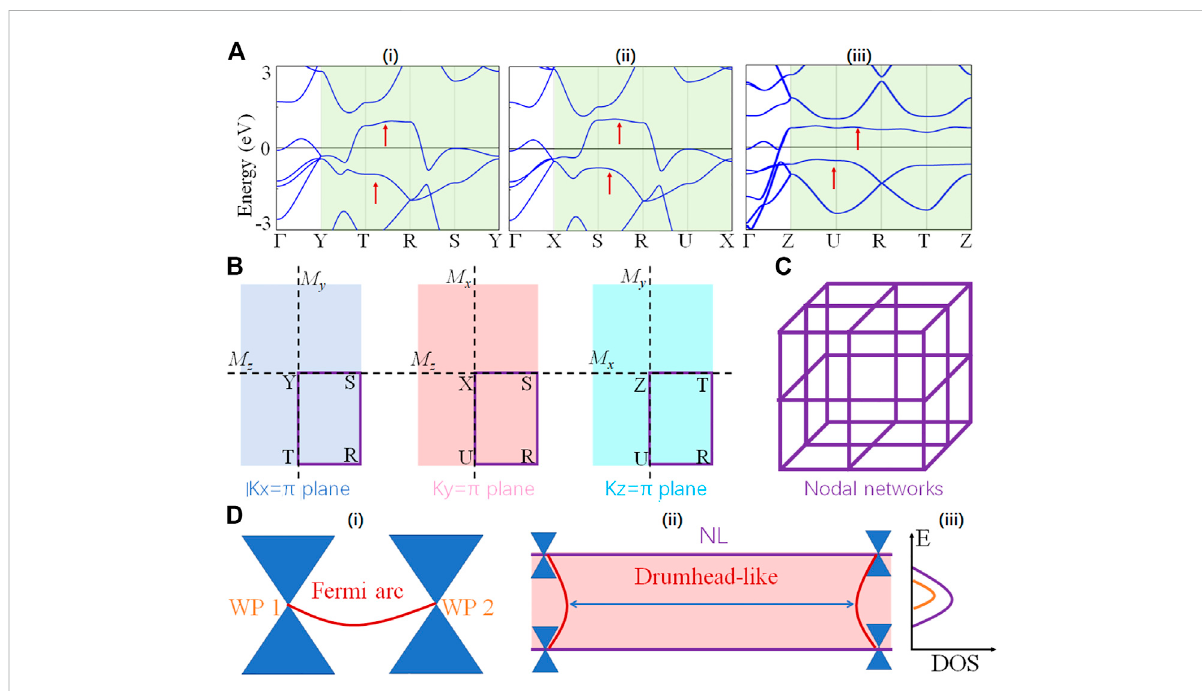
FIGURE 3 (A) Electronic band structures along k-paths (i) Y-S-R-T-Y (k x = π ), (ii) X-S-R-U-X (k y = π ), and (iii) Z-U-R-T-Z (k z = π ) (B) Different surfaces of LiRuO 2 in momentum space, where these purple lines represent the node lines. These nodal lines fi nally form the nodal networks on different surfaces (C) . (D) Schematic diagram of the surface states for (i) Wey point (WP) and (ii) nodal line